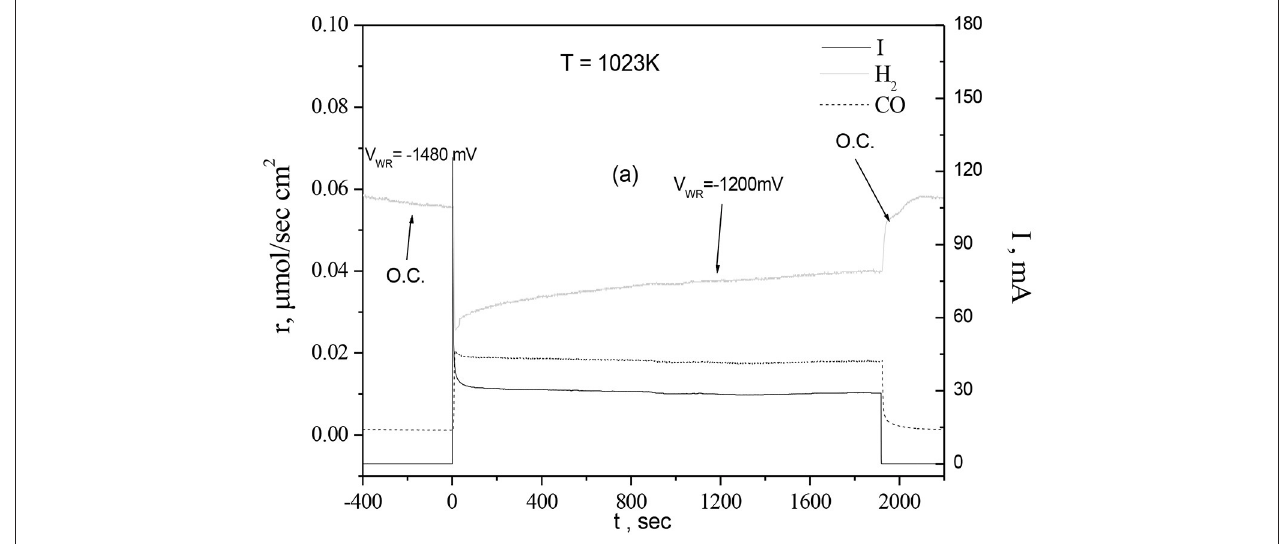
FIGURE 3 | Dynamic response of the production rate of H 2 and CO at T = 1,023K) on NiAu5%at/YSZ upon constant voltage application. Reprinted with permission from Gavrielatos et al.